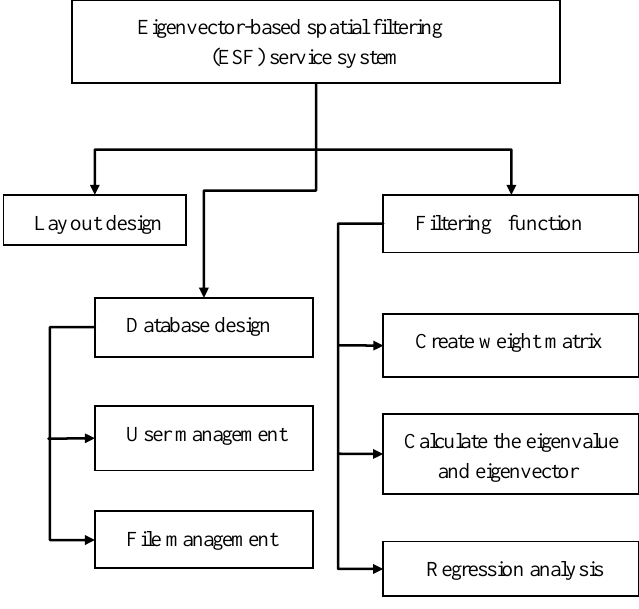
Figure 3. Service architecture